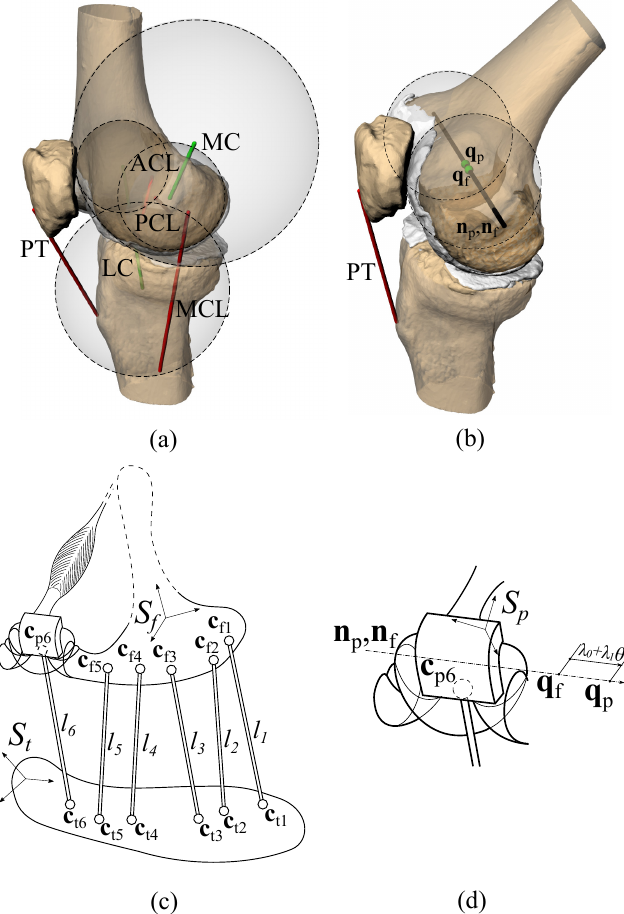
Figure 2. The kinematic model of the knee joint. Figures ( a , b ) show the anatomical derivation of the tibio–femoral group (TF group) and the patello–femoral group (PF group); Figures ( c , d ) show the analytical scheme of the whole knee model and a close up of the PF group, together with the model geometrical